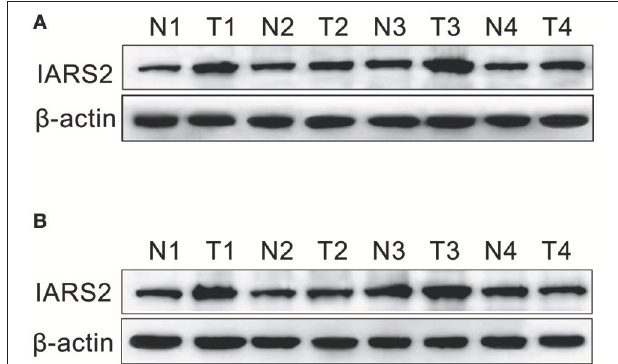
FIGURE 1 | Western blotting of IARS2 protein expression in representative tissue samples from NSCLC (T) and non-tumor specimens (N). Total protein was extracted, subjected to western blotting analysis, and quantified using Image J software. (A) Squamous cell carcinoma tissue. (B) Adenocarcinoma tissue.